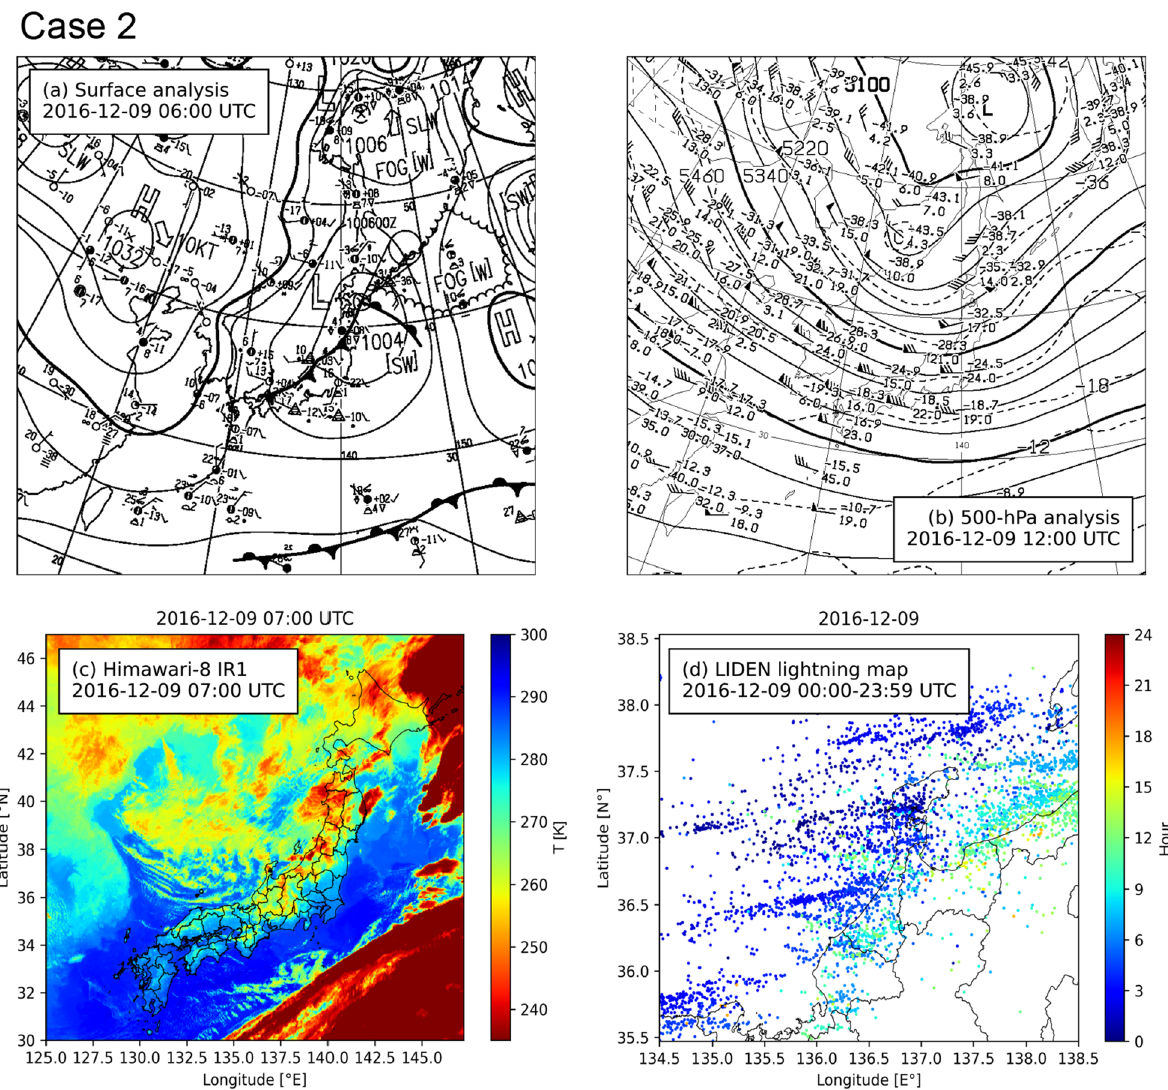
Fig. 9 Meteorological charts of the glow-detection Case 2 in the same format as Fig.